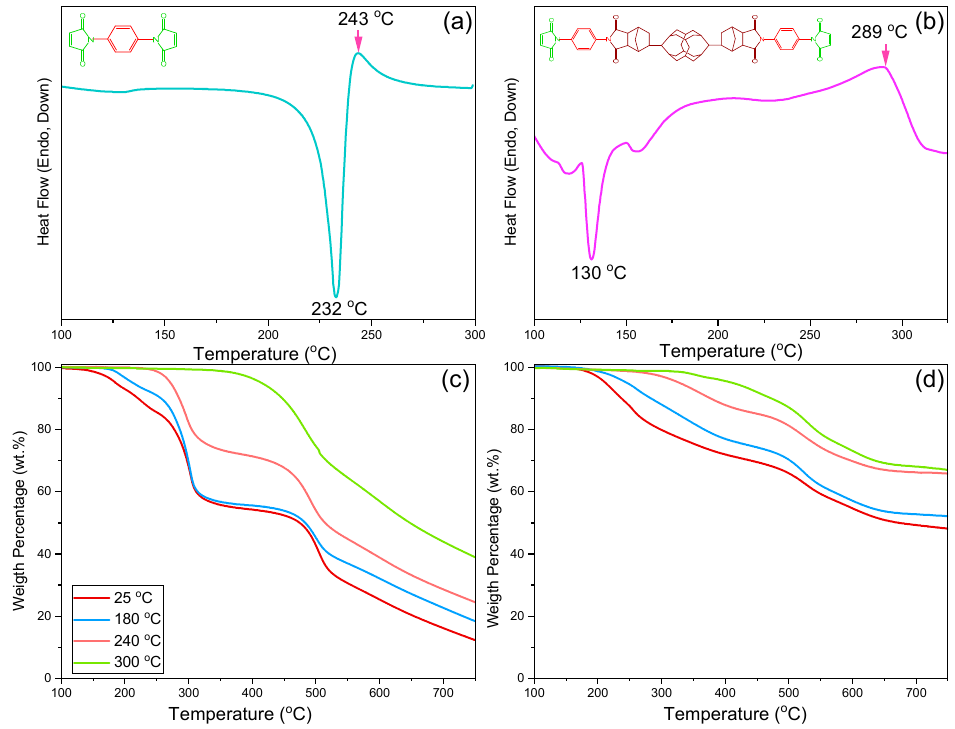
Figure 2. DSC analyses of ( a ) BMI and ( b ) DDSQ-BMI of the first heating run, TGA analyses of ( c ) BMI and ( d ) DDSQ-BMI after each thermal polymerization procedure.